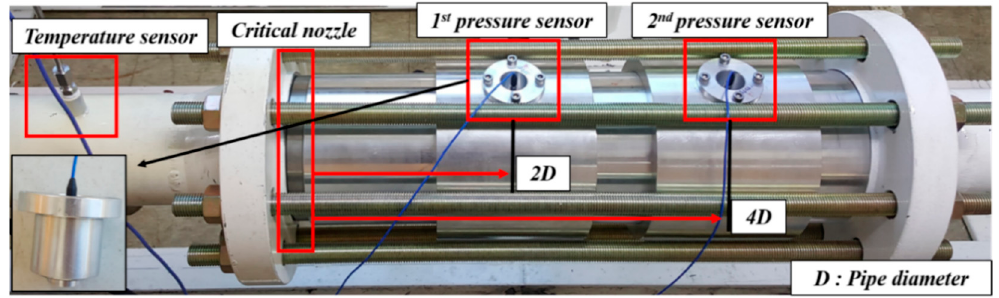
Figure 3. Experimental setup for acoustic induced vibration (AIV) measurement.